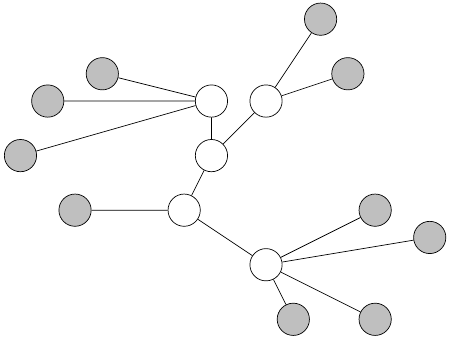
Figure 4. A spanning tree given by the white nodes. Leaf nodes are colored in grey.